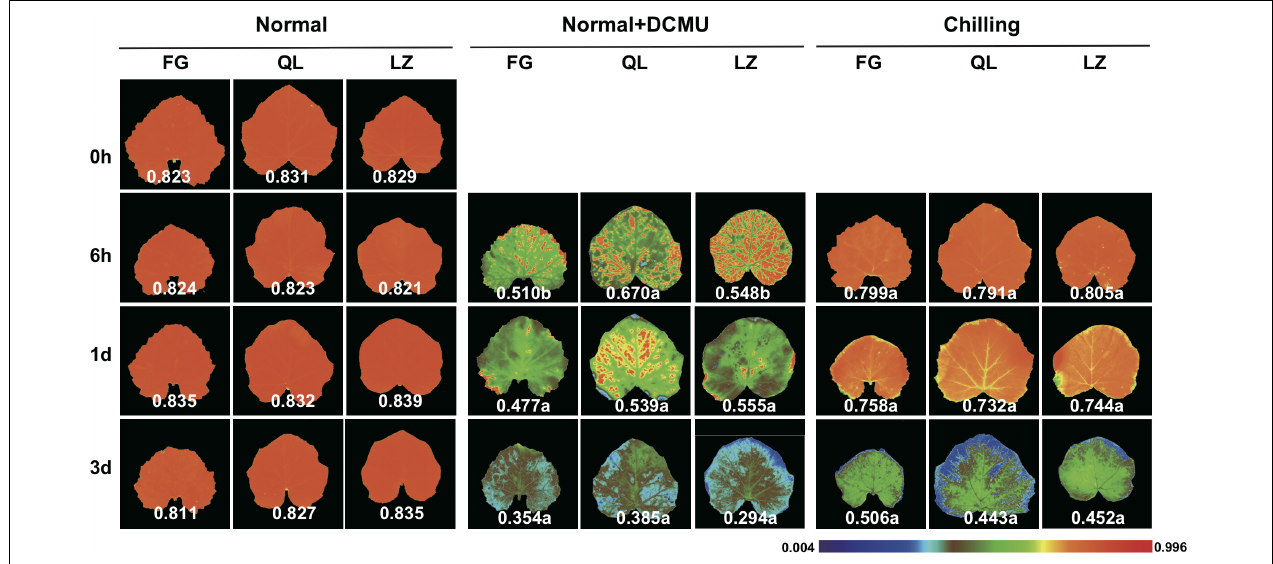
FIGURE 5 | The effect of DCMU application on the chlorophyll fluorescence ( Fv / Fm ) of first leaf under different conditions. Three individual plants at each time points were used for analysis. Student t -test was used to analyzed the significant difference. Different letters indicate significant difference in each time points comparing with normal ( P <